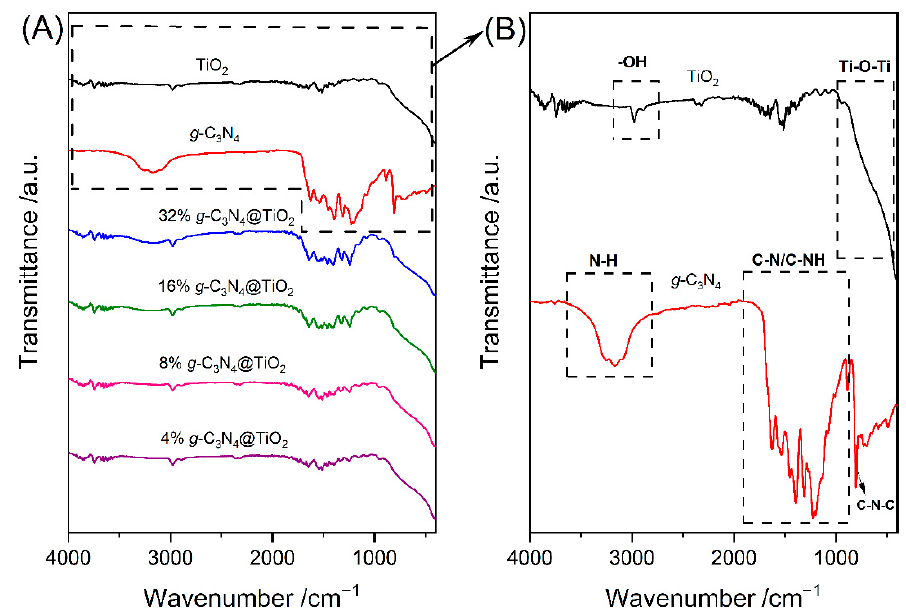
Figure 2. ( A ) FTIR spectra of the representative samples and ( B ) pure TiO 2 and g -C 3 N 4 .